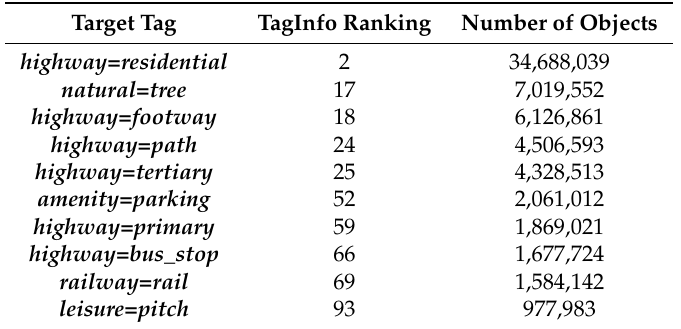
OSM tags according to TagInfo. The selected tags in the table qualify under the selection criteria outlined in Section 3.1. The overall TagInfo ranking is provided with the number of objects in the global OSM database, which contains the corresponding target